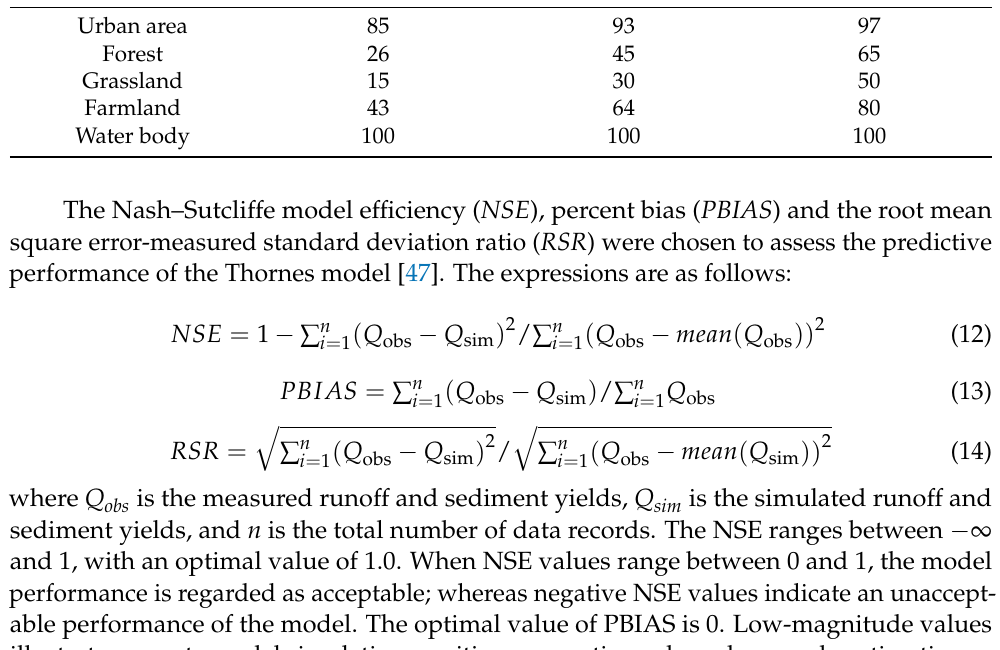
Table 2. Estimated CN values of different land use types under three antecedent moisture conditions. Antecedent Moisture Conditions Land Use Type AMC I AMC II AMC III Urban area 85 93 97 Forest 26 45 65 Grassland 15 30 50 Farmland 43 64 80 Water body 100 100